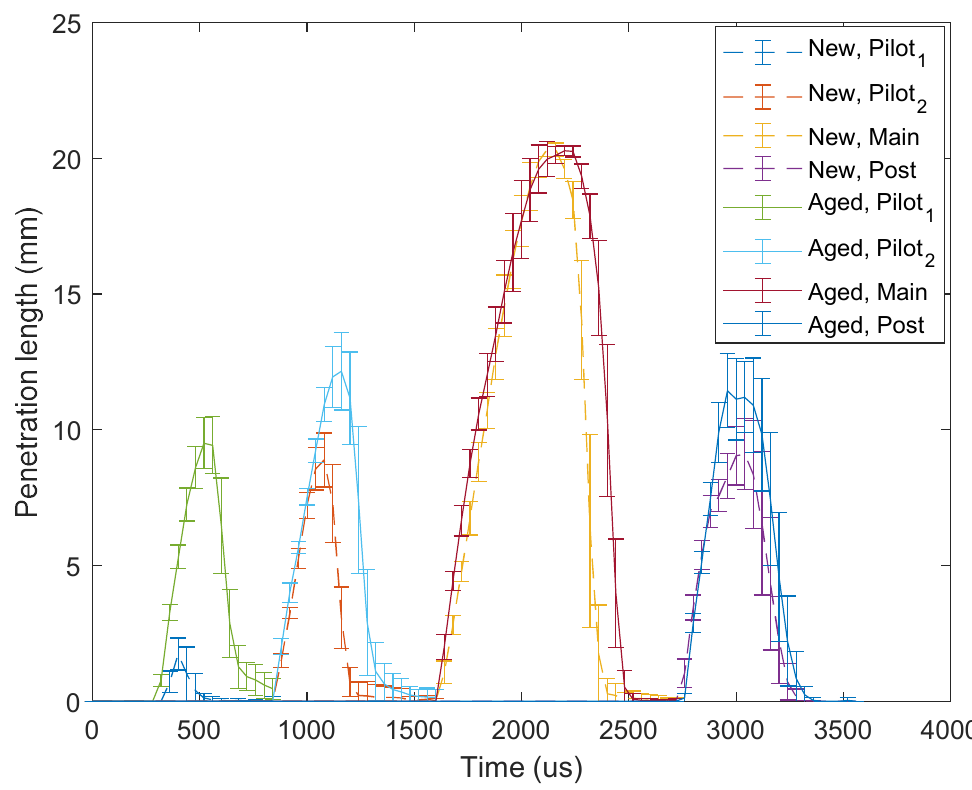
Figure 11. Spray penetration at low load using new and aged injectors.